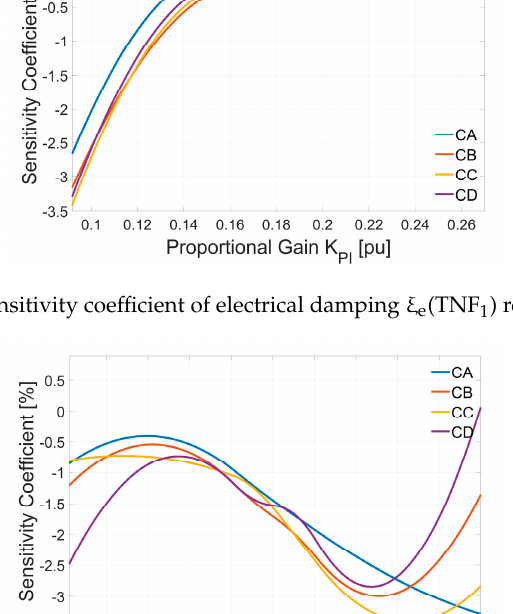
Energies 2020 , 13 , x FOR PEER REVIEW Figure 24. Sensitivity coefficient of electrical Figure 25. Sensitivity coefficient of electrical Figure 25. Sensitivity coe ffi cient of electrical damping ξ e (TNF 1 ) related to K PLL .